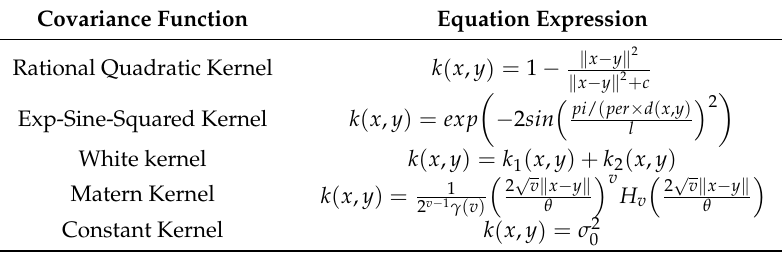
Table 2. Summary of several commonly used covariance